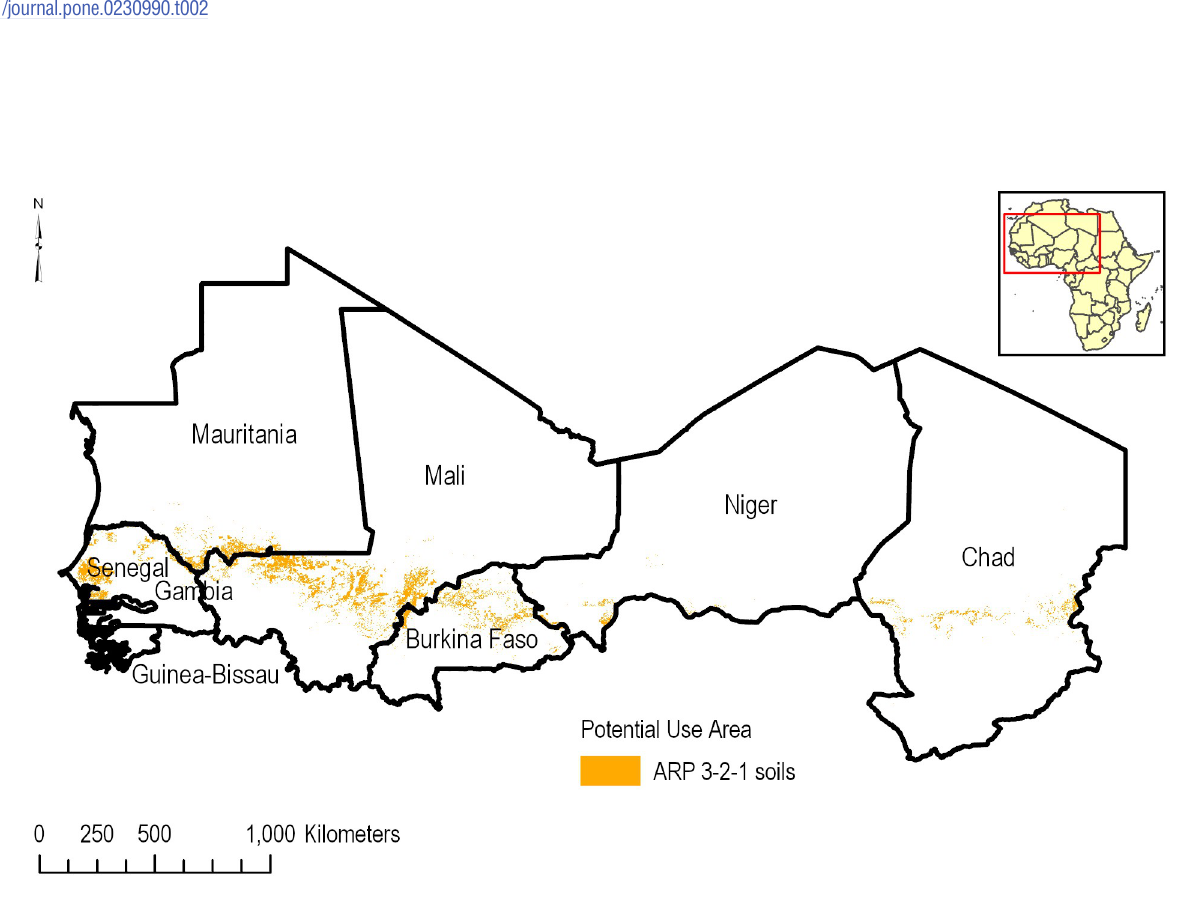
Fig 10. Spatial distribution of the ARP 3-2-1 soils in the